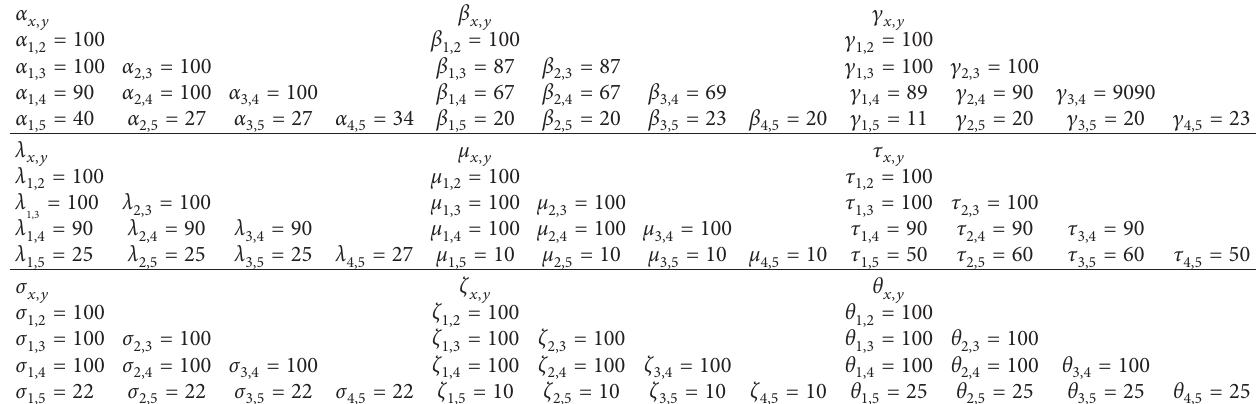
Table 10: Percent of vehicles remain in a parking lot from one interval to another